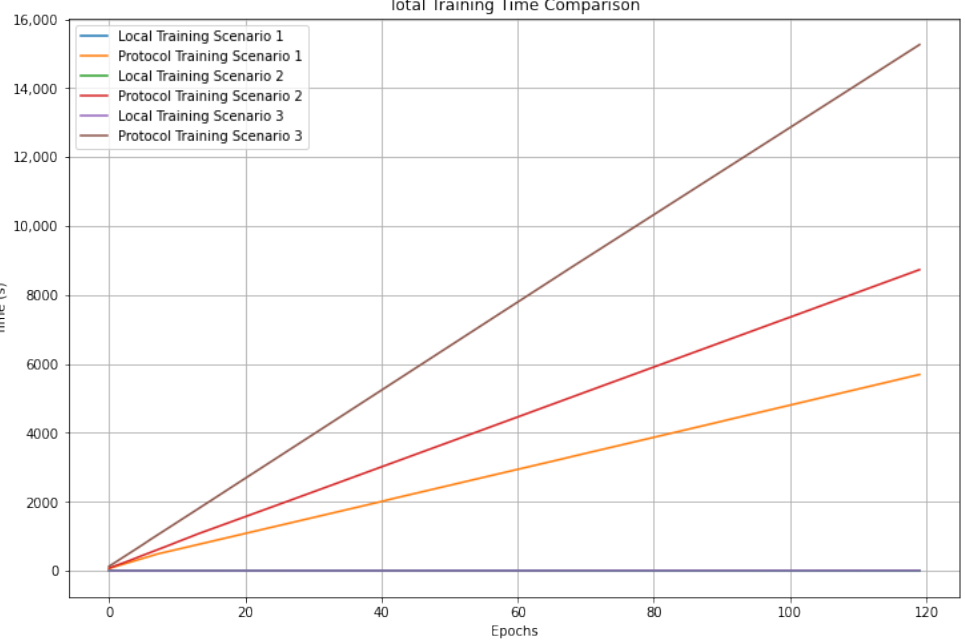
Figure 11. Comparison of training times for all